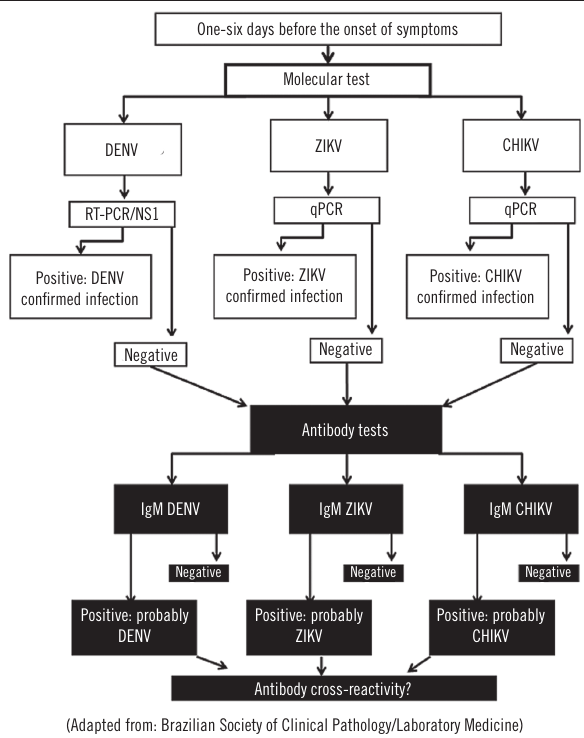
figurE 2 − Flowchart for laboratory testing to detect arbovirus in suspected cases of DENV, ZIKV and CHIKV ZIKV: Zika virus; DENV: Dengue virus; CHIKV: Chikungunya virus; RT-PCR: real- time polymerase chain reaction; qPCR: quantitative polymerase chain reaction; NS1: nonstructural protein; IgM: immunoglobulin class